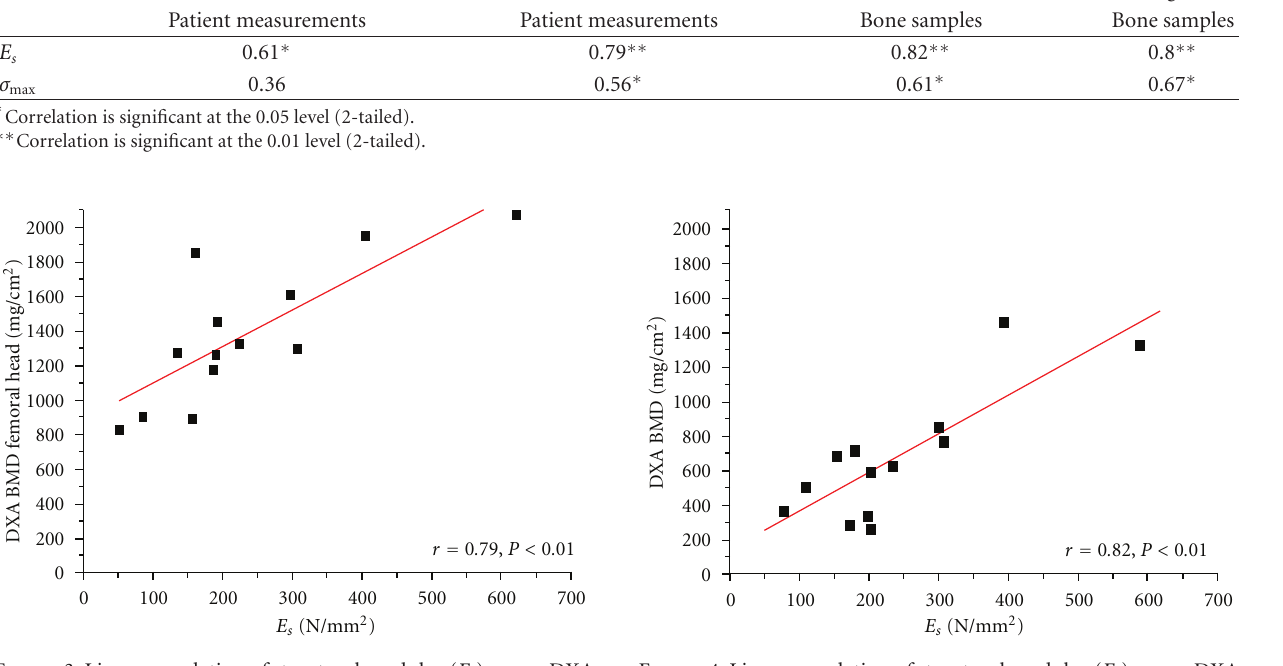
Figure 4: Linear correlation of structural modulus ( E s ) versus DXA BMD (on bone